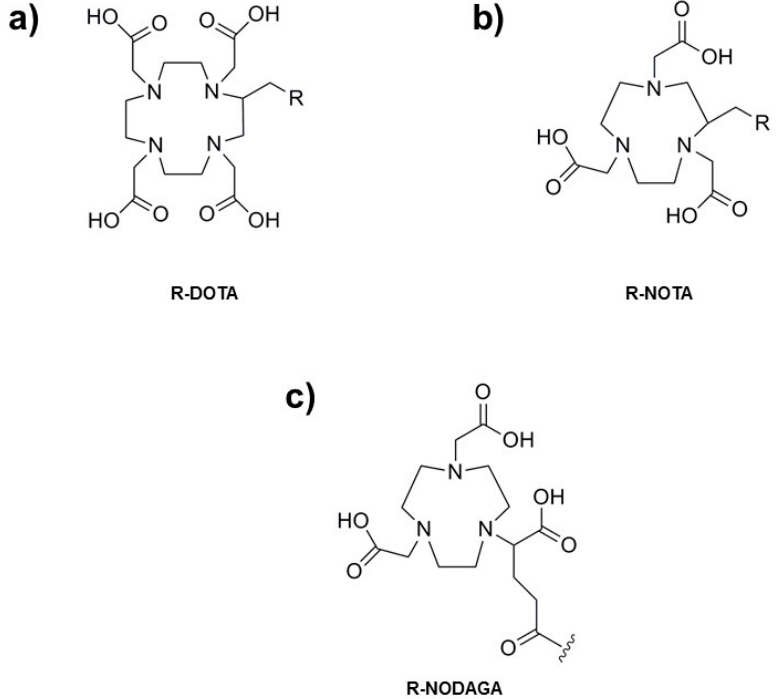
Figure 2. Most common 68 Ga chelators: ( a ) R-DOTA; ( b ) R-NOTA; and ( c ) R-NODAGA.